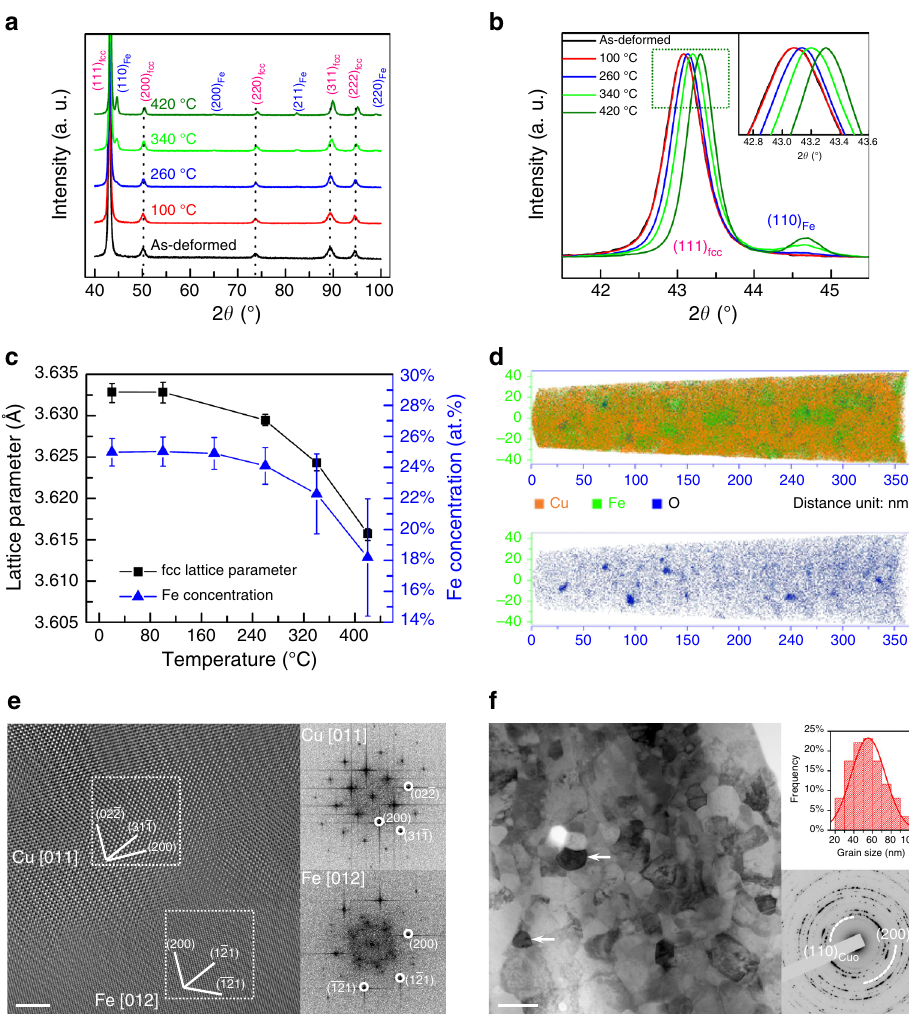
Fig. 3 XRD, EDXS, APT and TEM characterizations of ex situ annealed samples. a Full range XRD pro fi les of 75Cu – 25Fe samples ex situ annealed at different temperatures. b Fine scanning XRD pro fi les focusing on (111) fcc and (110) Fe peaks. c Lattice parameter and residual Fe concentration in fcc matrix of samples annealed at different temperatures. d APT overview image of the 75Cu – 25Fe sample ex situ annealed at 300 °C and the corresponding oxygen map highlighting O-rich clusters. e HRTEM image of the sample ex situ annealed at 420 °C showing the neighboring Cu and Fe grains on zone axes of [011] Cu and [012] Fe , respectively. The two FFT images are calculated based on the Cu and Fe areas marked with white frames. f Low magni fi cation BF image of the sample ex situ annealed at 420 °C; the white arrows indicate Fe grains. The inset at top-right corner is a grain size statistics histogram, and the bottom-right diffraction pattern is from the same annealed sample. The scale bar in ( e ) is 2 nm and in ( f ) is